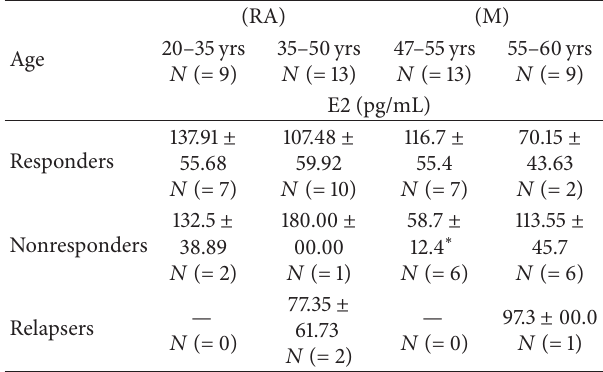
Table 6: The relation between fibrosis and estradiol level in reproductive aged and menopausal patients.